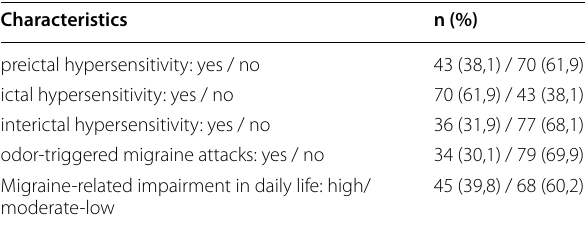
113 patients with =